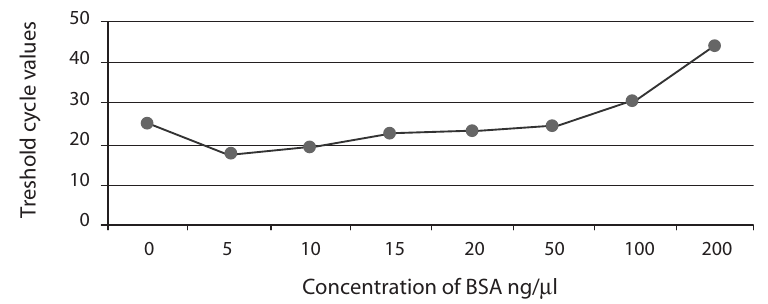
values and BSA T